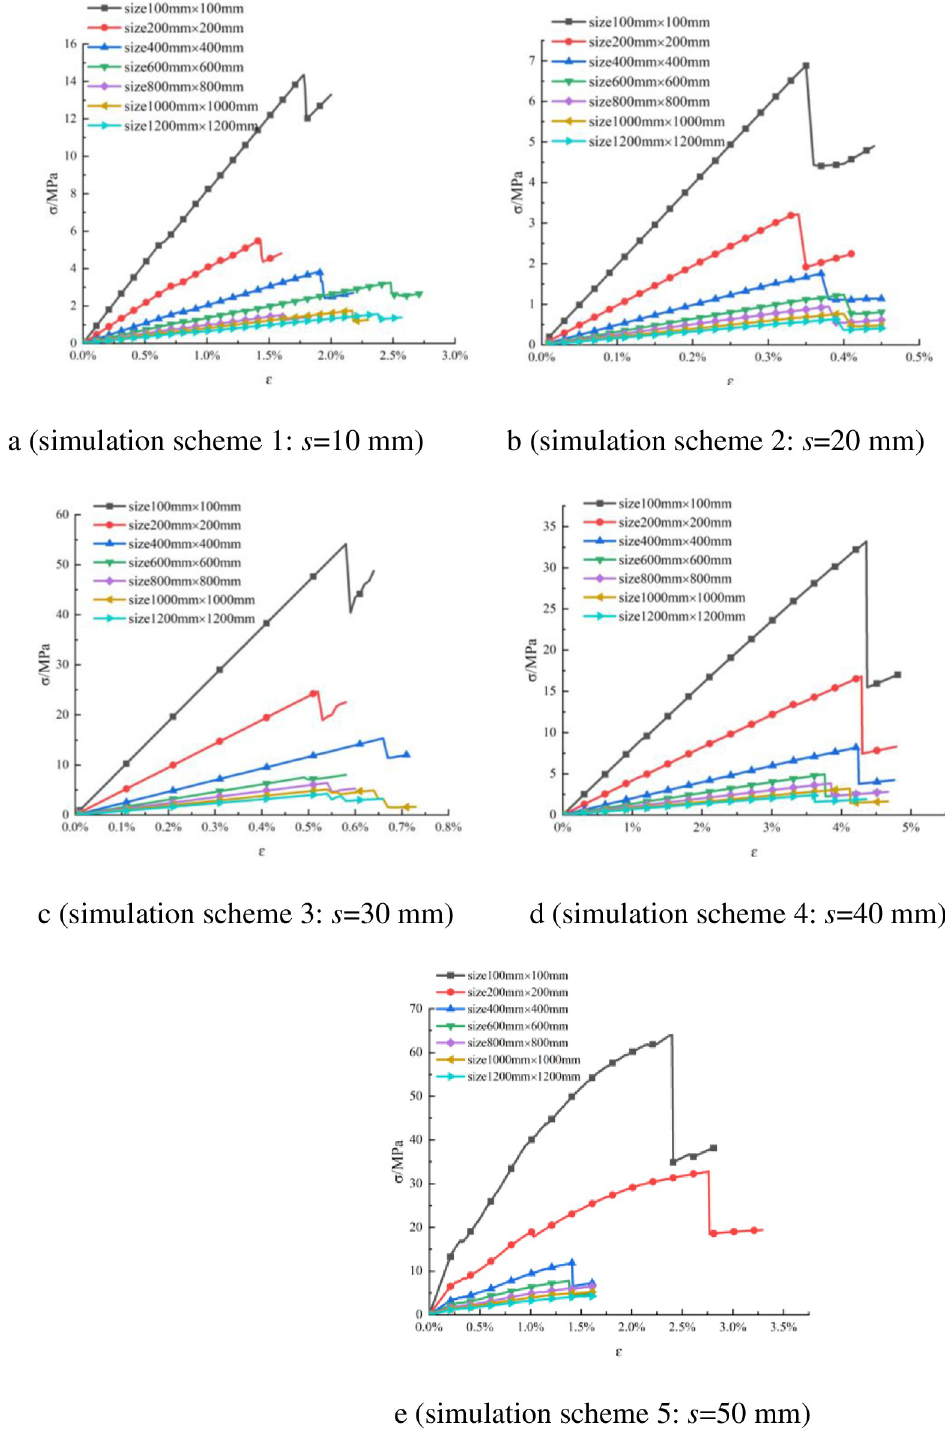
Fig 5. Stress–strain curves of different sizes of rock in uniaxial compression simulations.